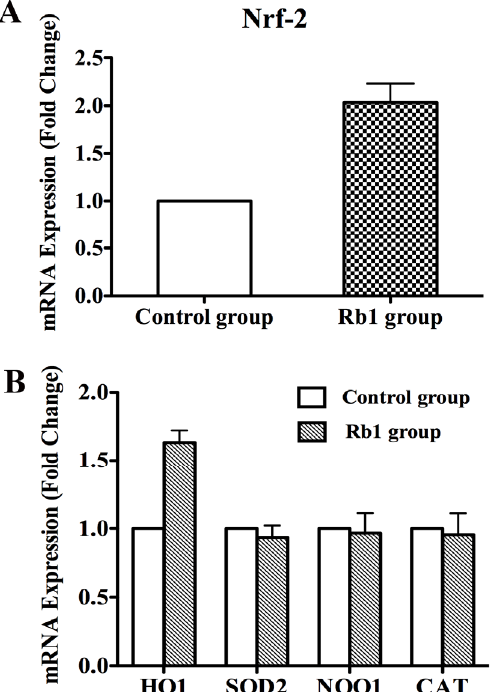
Figure 3. The mRNA expression levels of Nrf2, HO-1, SOD2, NQO1 and CAT in NPCs after pretreatment with Rb1. ( A ) Quantitative real-time PCR demonstrated that the expression level of Nrf2 increased by 2 fold in NPCs after treatment with 10 µM ginsenoside Rb1 for 24 h; ( B ) Quantitative real-time PCR to measure HO-1, SOD2, NQO1 and CAT levels in NPCs after pretreatment with 10 µM ginsenoside Rb1 for 24 h followed by incubation with 300 µM t -BHP for 2.5 h. The expression level of HO-1 was significantly elevated compared with the control group, whereas SOD2, NQO1 and CAT mRNA expression did not change after the same